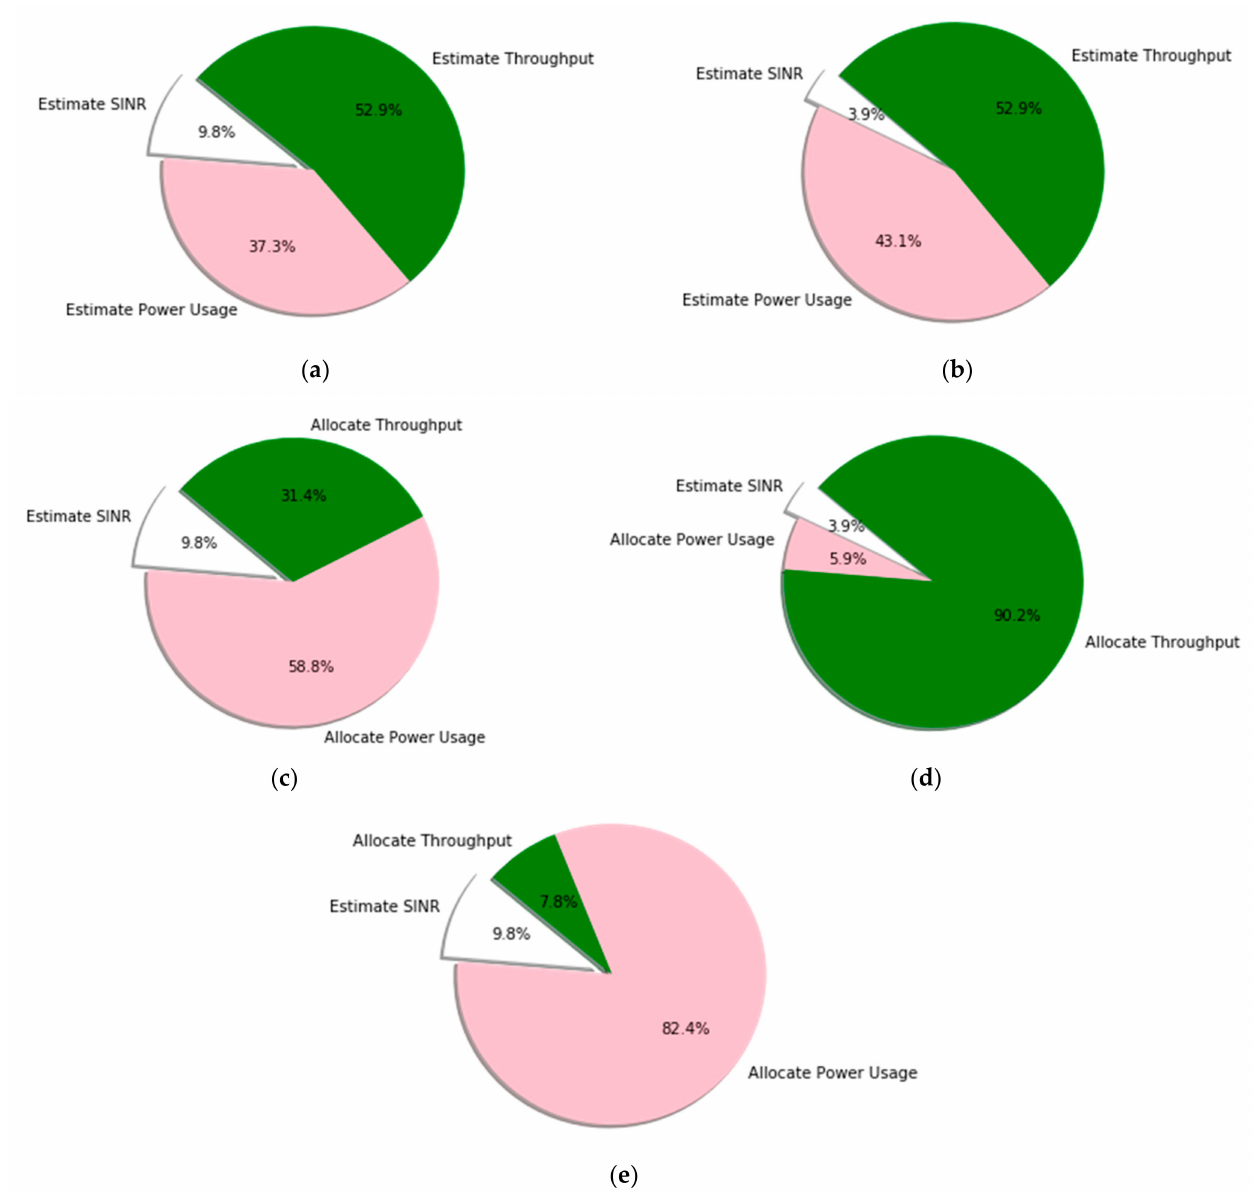
Figure 8. The average resource management of the target clusters for different schemes in different learning processes: ( a ) service request at cluster 1, ( b ) service request at cluster 2, ( c ) resource management at 30 m UAV altitude, ( d ) resource management at 60 m UAV altitude, and ( e ) average resource management without applying round